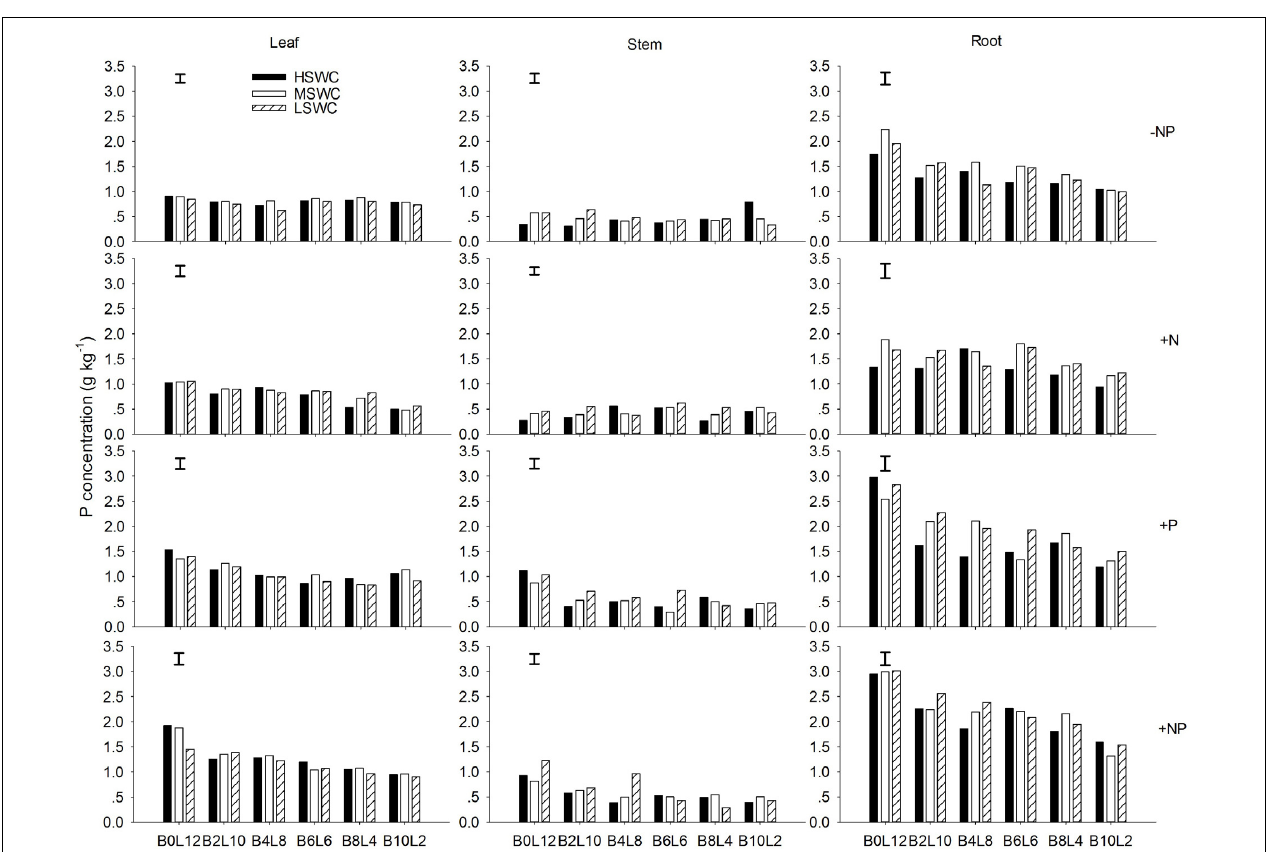
FIGURE 2 | Leaf, stem, and root P concentration of L. davurica (L) mixed with B. ischaemum (B) at various mixture proportions under three soil water regimes [HSWC: 80% FC (field capacity); MSWC: 60% FC; LSWC: 40% FC] and four fertilization treatments (–NP, +N, +P, +NP). B i L j ( i , j = 0, 2, 4, 6, 8, 10, 12; i + j = 12) means the plant numbers of B. ischaemum to L. davurica in their mixtures. Error bars are LSD ( p < 0.05).